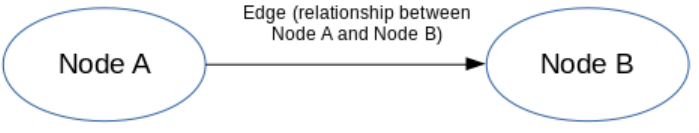
Figure 1. Basic graph with two entities and its relationship.